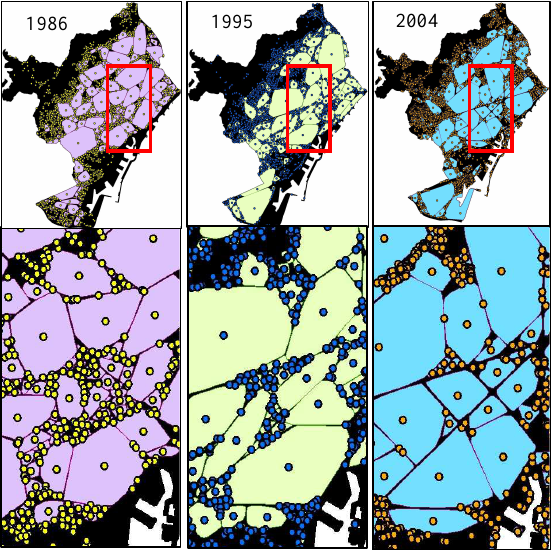
Figure 10: Centroid point dataset corresponding to multi- temporal joined cluster areas.